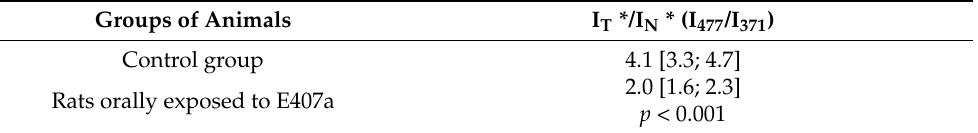
Figure 4. Representative fluorescence spectra of probe O1O in leukocyte suspensions: ( a ) the control group of rats (black solid line); ( b ) the animals orally exposed to E407a for two weeks (red solid line). For a correct comparison, the spectra were normalized to the fluorescence intensity of the normal form. Table 2. The ratio of the fluorescence intensities of the photo-tautomer and normal forms (I T */I N *) of probe O1O in the leukocyte membranes of rats orally exposed to E407a (Me [IQR]).